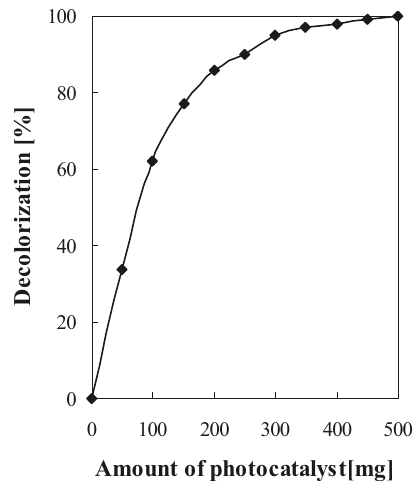
Figure 2. Effect of photocatalyst on decolorization efficiency.